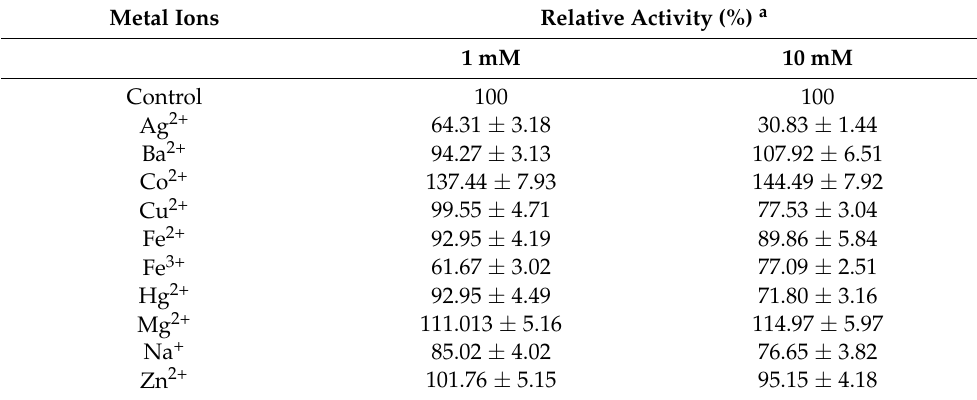
Table 3. Effect of different metal ions on Beauveria bassiana SAN01 xylanase activity.